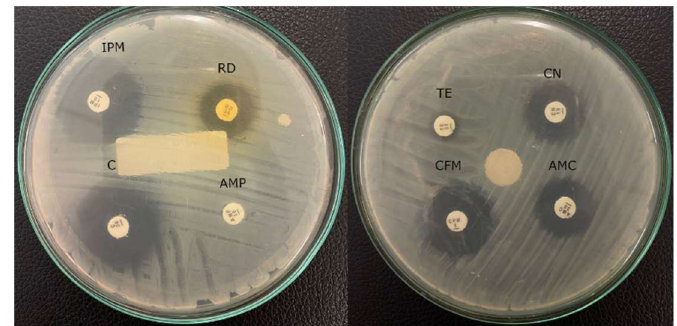
Figure 2. Antimicrobial susceptibility test result of TB1 isolate against eight different antibiotics using disk diffusion method.